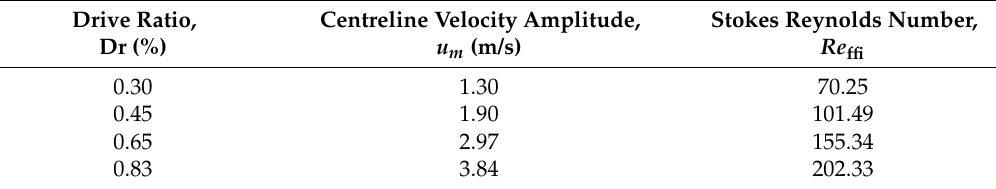
Table 1. Stokes Reynolds number based on the experimental results of Shi et al. [16,17]. Drive